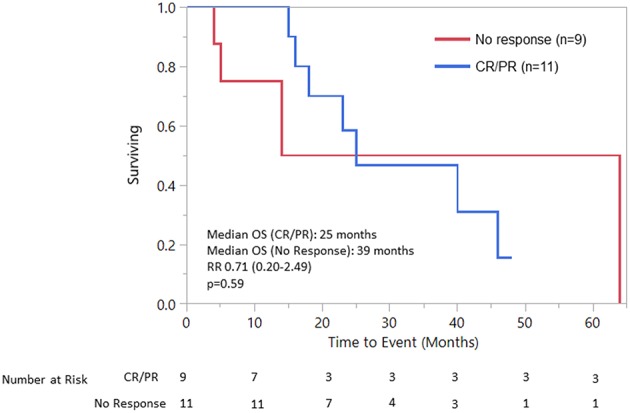
OS response to 1st line ADT vs. No response to 1st line ADT.